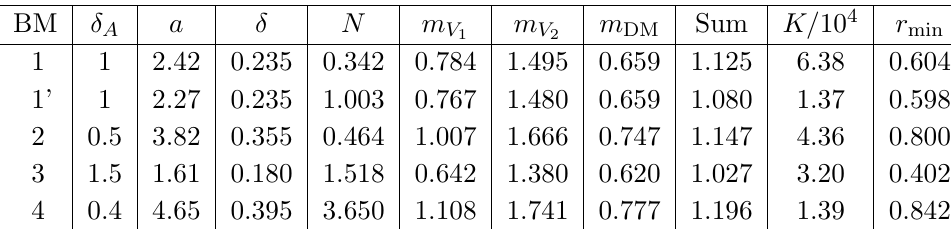
Table 1 . Parameters and general properties of the (cid:12)nal (cid:12)ve chosen Dirac DM BM models; all masses are given in units of R (cid:0) 1